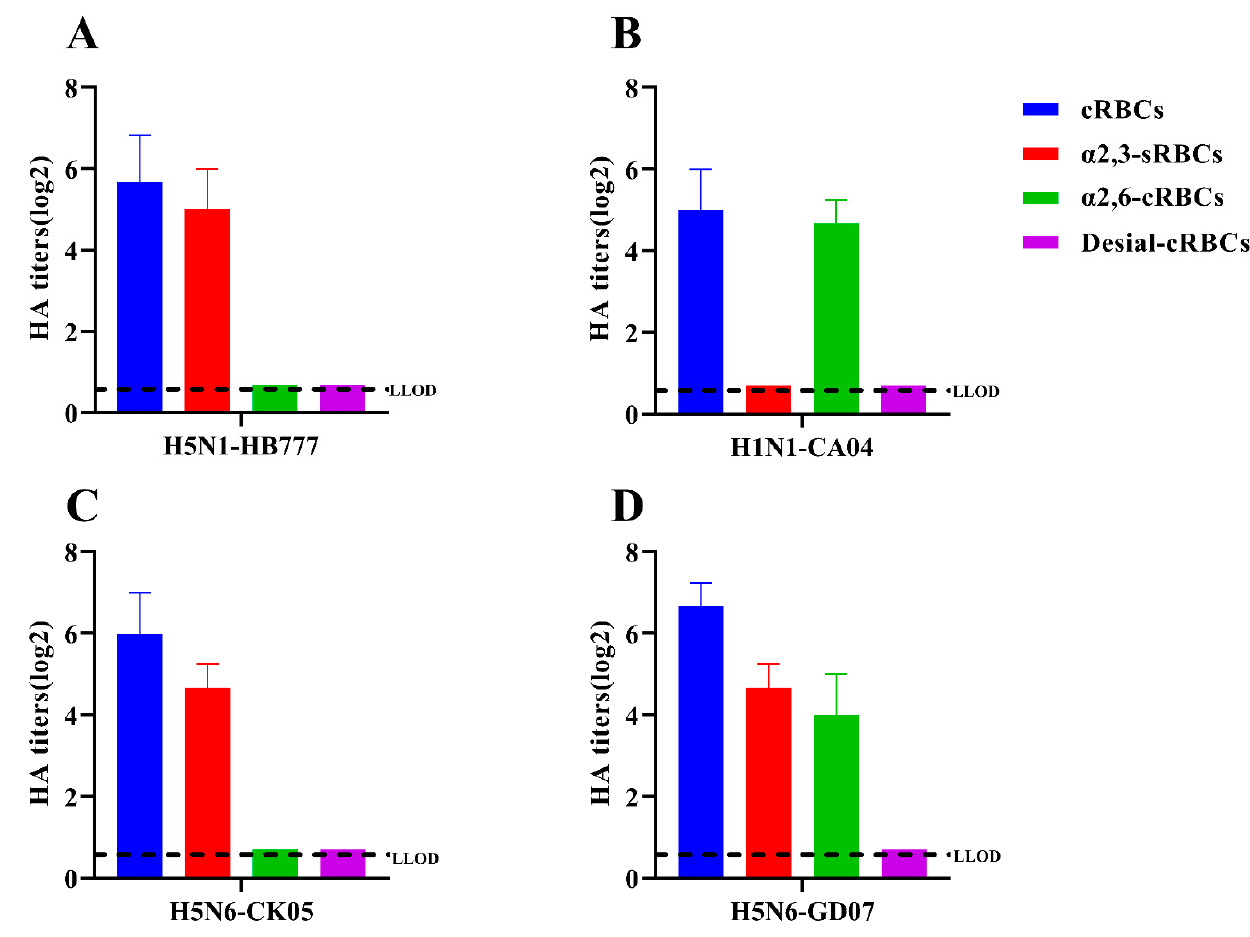
Figure 2. Receptor-binding specificity of H5N6 (CK05 and GD07) viruses. The receptor-binding specificity of viruses is determined by RBCs containing different SA receptors. Only avian-like ( α -2,3) receptors were found in the control group, HB777(H5N1) ( A ), while only human-like ( α -2,6) receptors were found in CA04(H1N1) ( B ). Avian-like (-2,3) receptors were found in both CK05 ( C ) and GD07(D). Human-like (-2,6) receptors are present only in the GD07 ( D ) strain. In each group, three separate experiments were carried out. The lower limit of detection (LLOD) is indicated with a black dotted line.